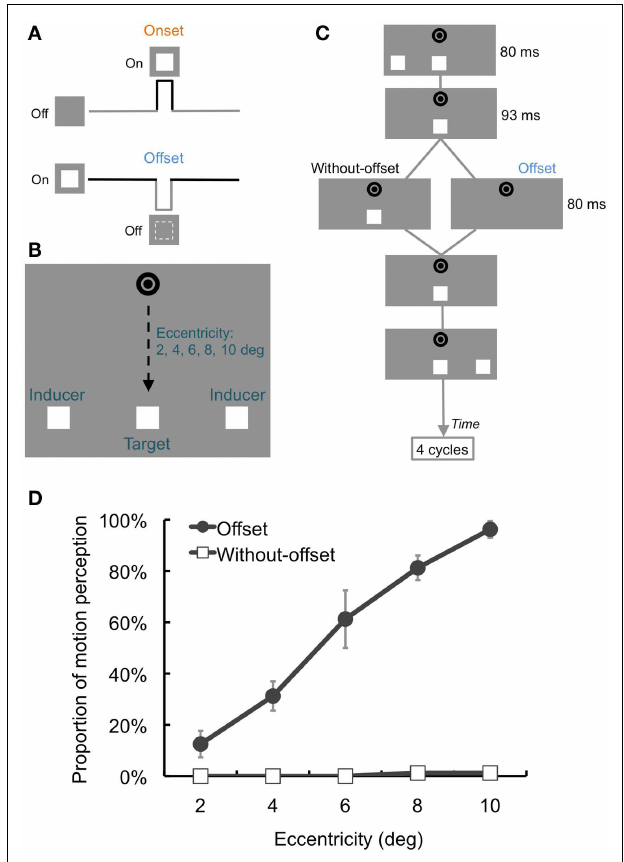
FIGURE 1 | Schematic illustrations of the stimuli, procedures, and results of Section “Experiment 1.” (A) Onset and offset signals.Whereas the onset signal contains on-off transient changes, the offset signal contains opposite off-on transient ones. (B) Stimuli.The target stimulus was presented in-between apparent motion (AM) trajectory with 2–10˚ of eccentricity. (C) Time course of stimulus presentation.The target continuously appeared during AM in theWithout-offset condition, while the target transiently disappeared for 80ms in the Offset condition.The target position was fixed in either case. AM sequences were presented for four cycles. (D) Results. Proportion of illusory motion perception perceived for the target.The proportion gradually increased with the increment of the eccentricity. Error bars denote standard errors of the mean ( N =